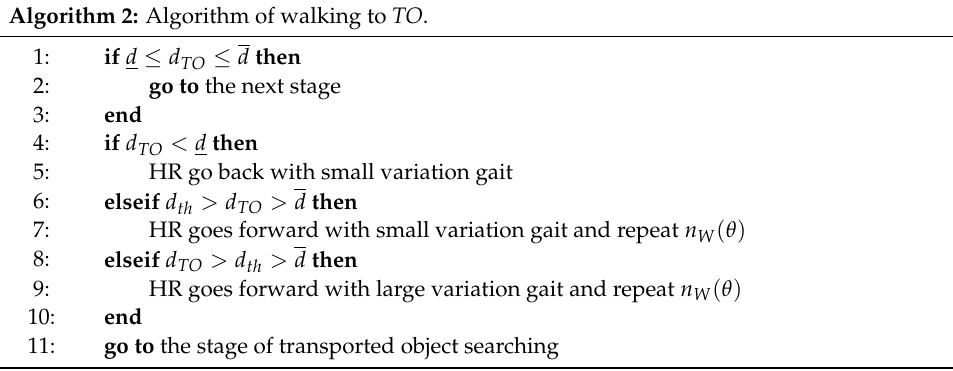
Algorithm 2: Algorithm of walking to TO